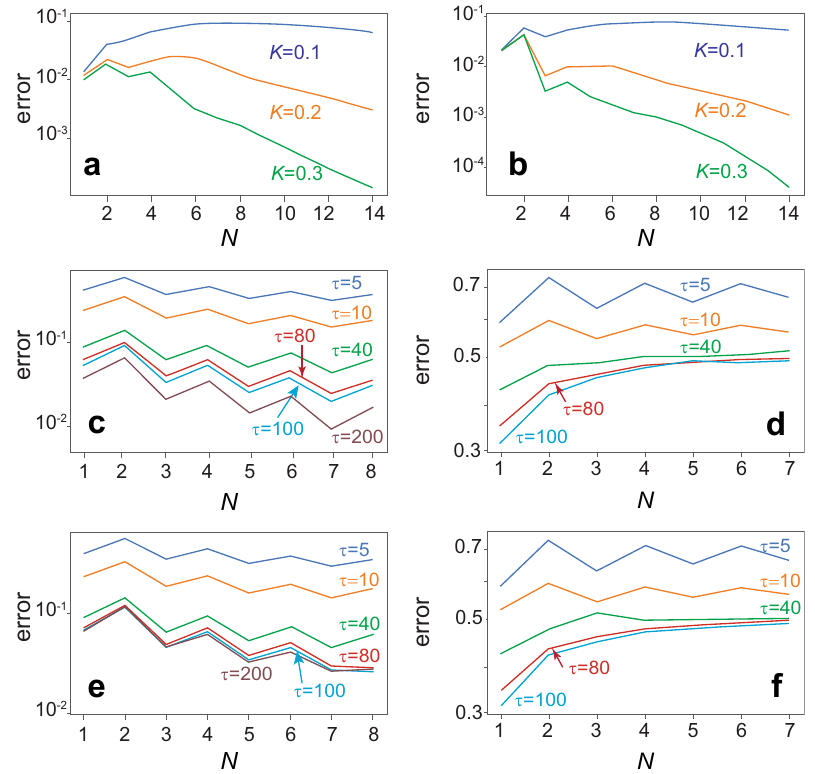
Fig. 4 Error probabilities in the time-evolved adiabatic quantum computation. a , b Error vs. N for the ferromagnetic model with M = 3, J ij = = K , and τ = 100. The critical ensemble size for each parameter is: N = 0.1) = 14, N = 0.2) = 8, N = 0.3) = 5. Dephasing − 1(1 − δ ij ) and K i c ( K c ( K c ( K in the basis ( a ) S z -basis with Γ z = 10 − 4 and ( b ) S x -basis with Γ x = 10 − 4 are calculated. c , d Averaged error vs. N for various τ and M = 3 for ( c ) 60 problem instances with N c = 3; ( d ) 60 problem instances with N c > 7. Averaged error vs. N for various τ and M = 3 including dephasing of rate = 3; ( f ) N Γ = 10 − 4 for the same problem instances with ( e ) N c c >